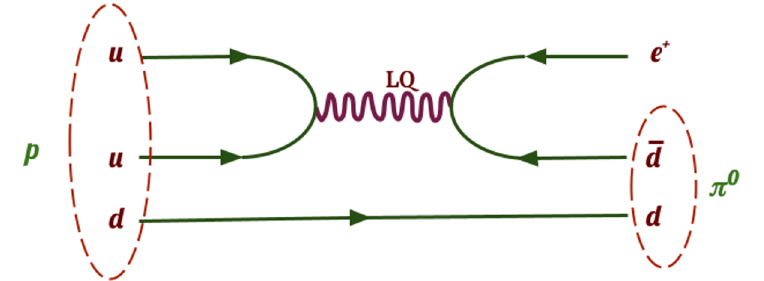
Figure 2 . Proton decay mediated by leptoquark gauge bosons contained in adjoint representation of SO(10)